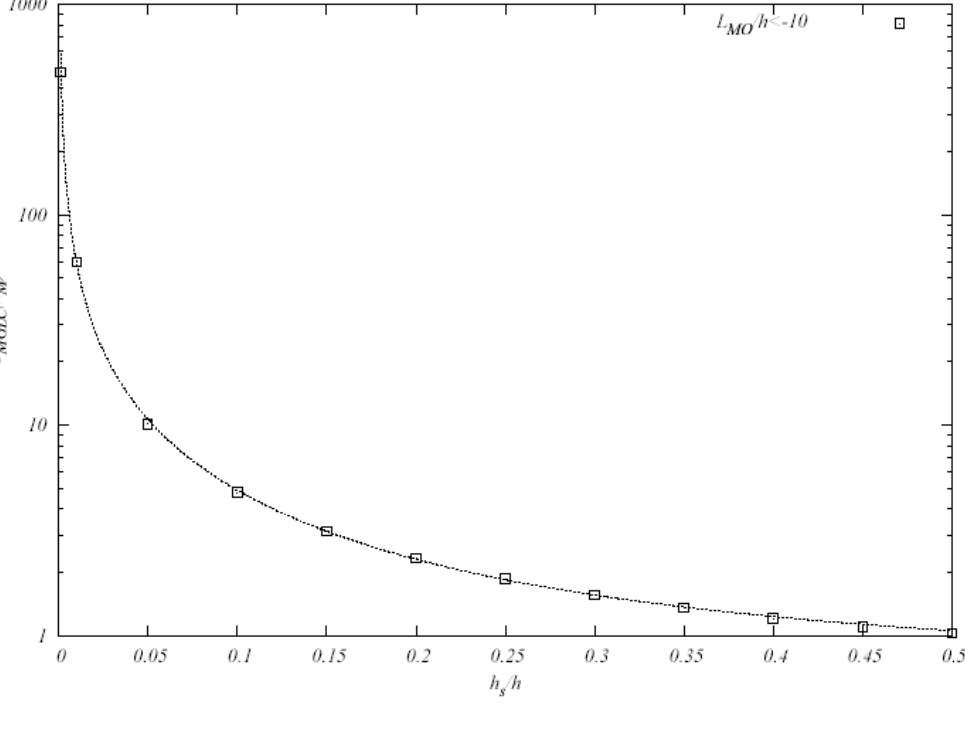
/~  . Points refer to ss